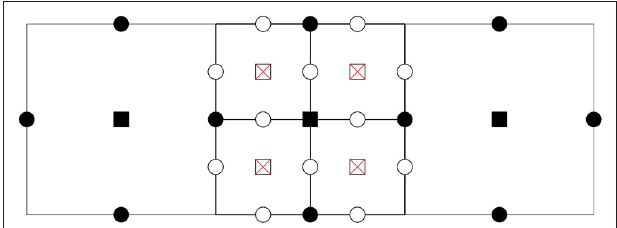
FIGURE 2 | Simplified plan view of a 2D computational domain containing a single patch. The Cartesian grids are nested and the fine one (which is inside the central coarse cell) has a spatial refinement factor of 2:1. E - and v e -field are represented by circles, H -field is represented by squares and plasma variables (i.e., n e , ε e , ν eff , etc .) are represented by red crosses. Full and empty circles (or squares) denote the coarse and the fine grid,